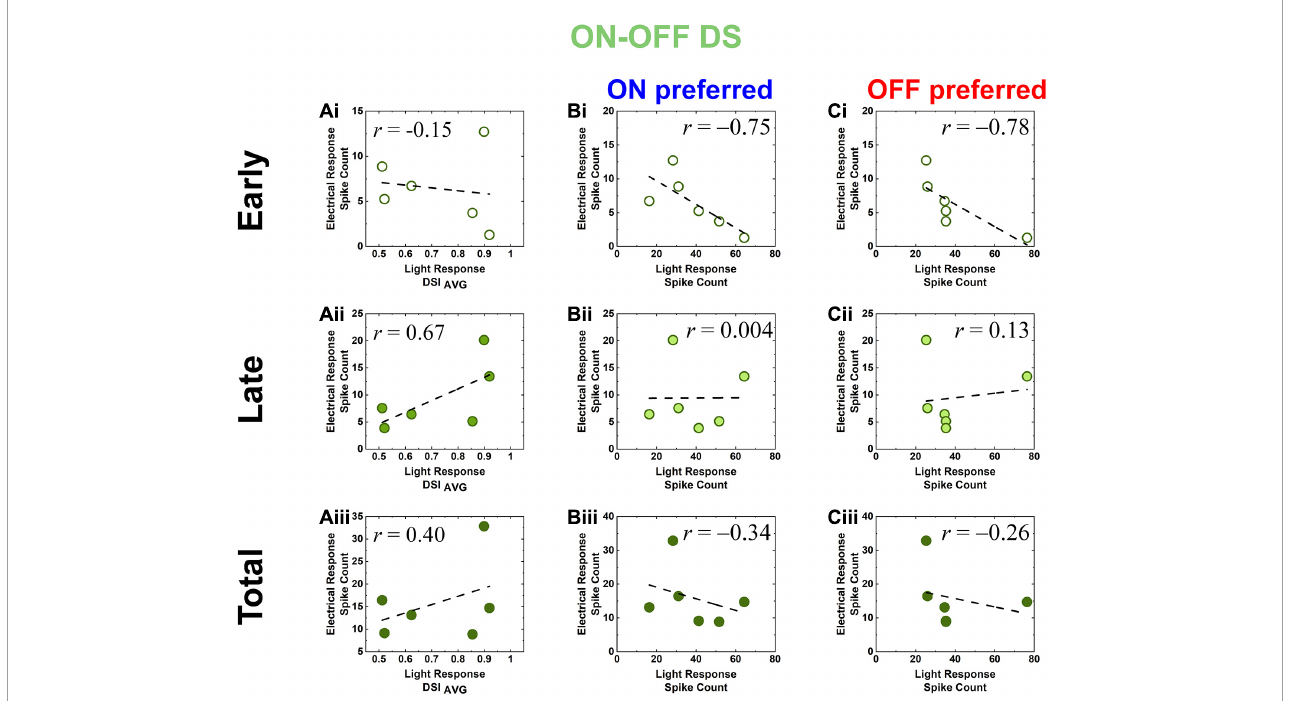
FIGURE6 Electric response magnitudes (spike count) of DS RGCs in rd8 and wt retinas show opposite correlations with their direction selectivity indices and light response spike count. (Ai–Aiii) Scatter plots of electric response [early, late, and total responses in panels (Ai–Aiii) , respectively] spike count vs. light response DSI AVG in the same cell for all DS RGCs recorded from rd8 retinas. Each data point is from a different cell. Level of correlation ( r –value) is shown in each plot. Dashed line indicates linear fitting curve in each panel. (Bi–Biii) Scatter plots of electric response (spike count) vs. leading edge (ON) of moving bar light response (spike count) in the same cell for all DS RGCs recorded from the r d8 retinas. Scatter plots are shown for (Bi) early, (Bii) late, and (Biii) total responses, respectively. (Ci–Ciii) Same as panels (Ai–Aiii) but for trailing edge (OFF) of moving bar light